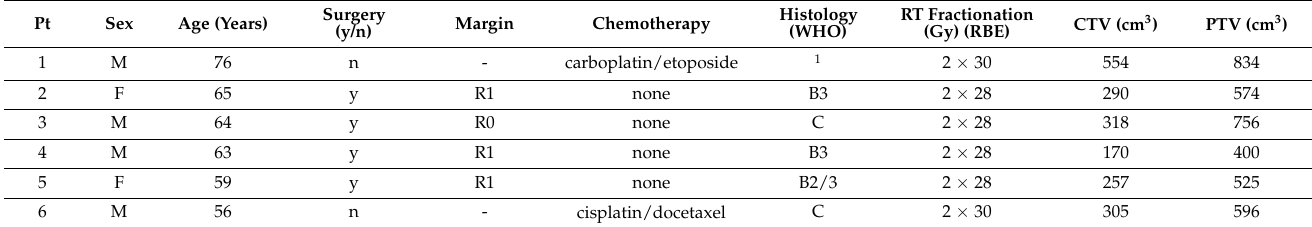
Table 1. Patient, tumor, and treatment